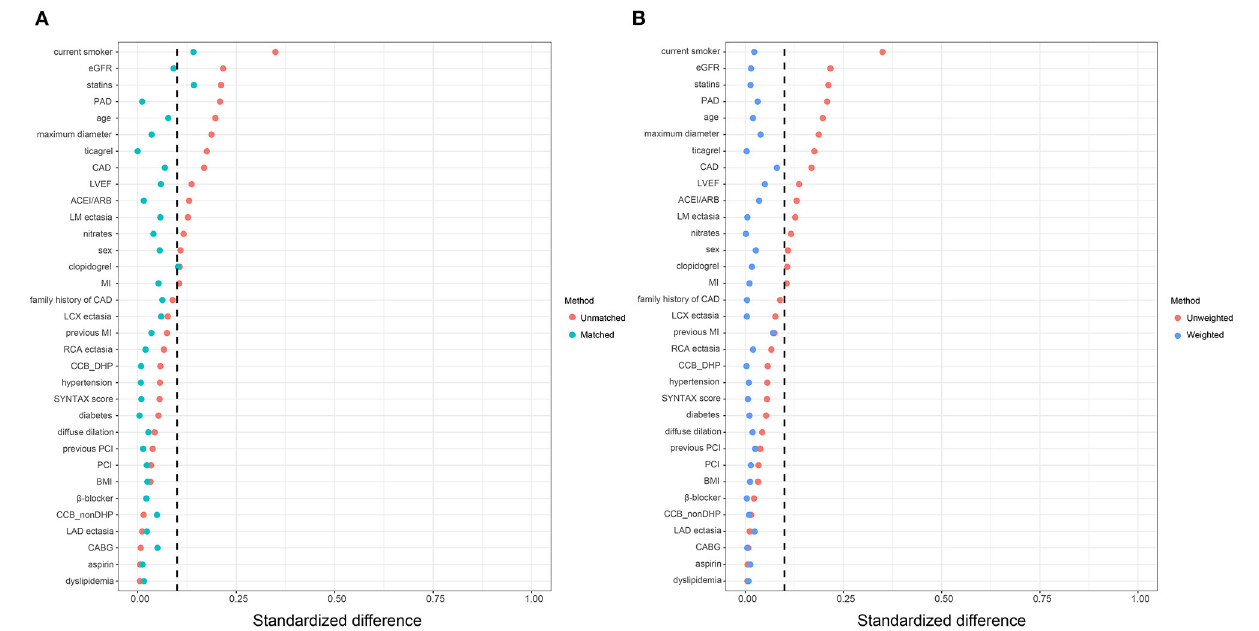
FIGURE 3 | Covariates balance in the study cohort. (A) Standardized difference before and after propensity score matching. (B) Standardized difference before and after propensity score weighting. ACEI, angiotensin-converting enzyme inhibitors; ARB, Angiotensin Receptor Blockers; BMI, body mass index; CABG = coronary